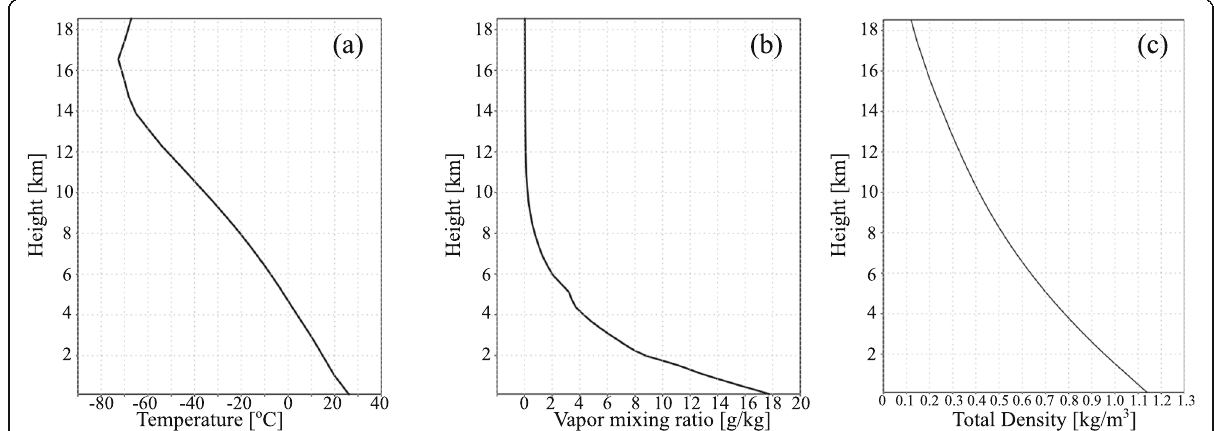
Fig. 2 The initial profiles of a temperature, b vapor mixing ratio, and c total density, which is defined as summation of density of air and vapor, used in this